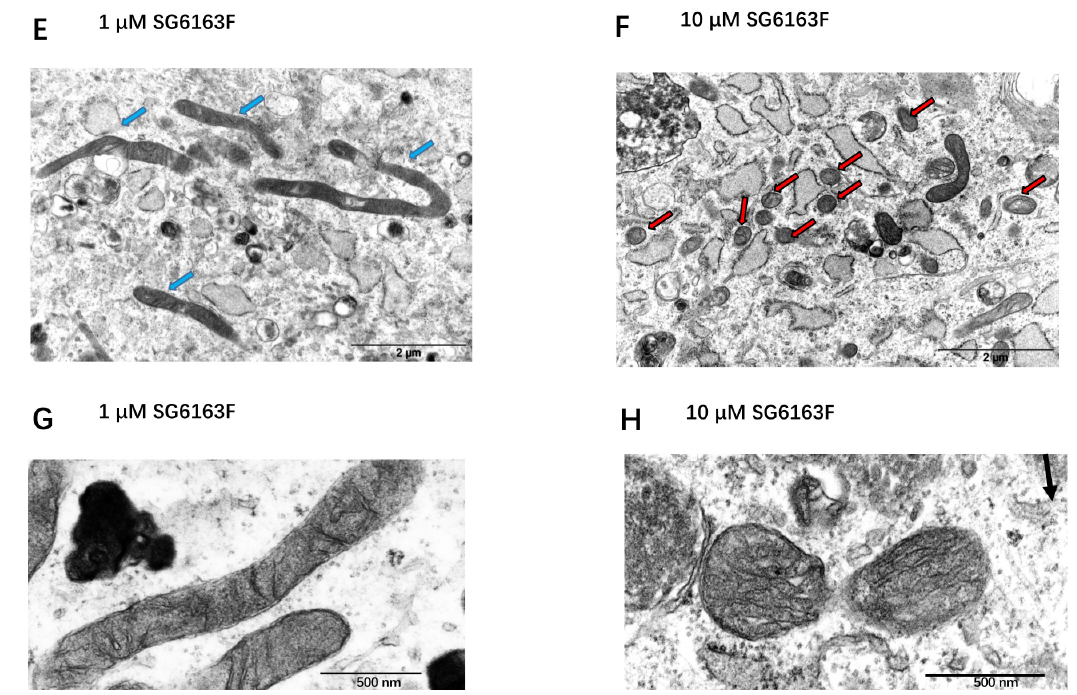
Figure 8. Mitochondrial morphology analysis in cells treated with SG6163F and digoxin by trans- mission electron microscopy (TEM). Cells were treated by 0.1% DMSO ( A , C ), 1 µM digoxin ( B , D ), 1 µM SG6163F ( E , G ), and 10 µM SG6163F ( F , H ), fixed by glutaraldehyde and analyzed by TEM. Blue arrows in ( A , E ) indicate the long and thin mitochondria, and the red arrows in ( B , F ) indicate short round mitochondria which suggest fission events.